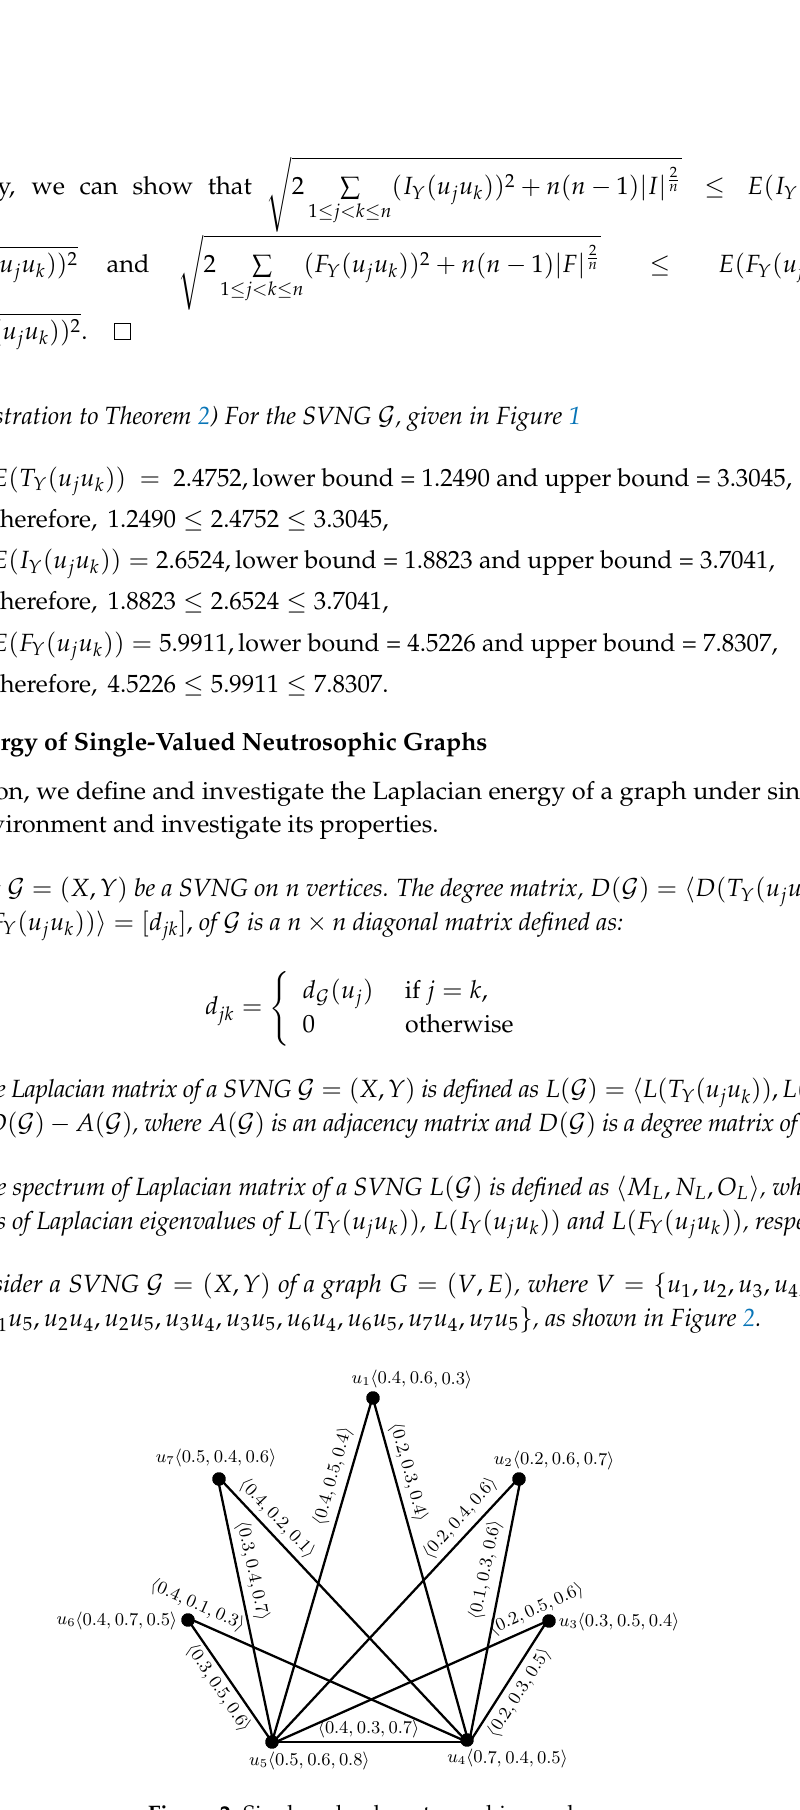
Figure 2. Single-valued neutrosophic Figure 2: Single-valued neutrosophic graph.